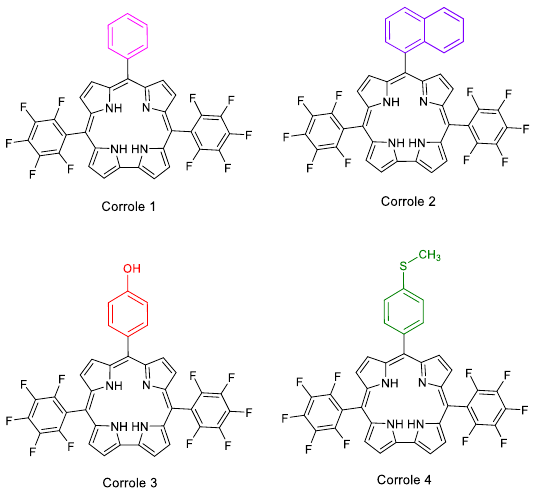
Figure 1. Chemical representative structure of mono-substituted corroles 1 – 4 .